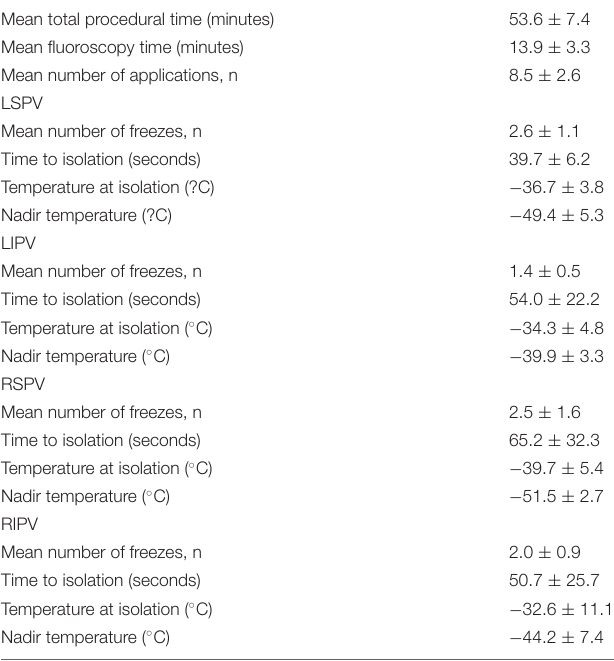
TABLE 2 | Procedural and biophysical